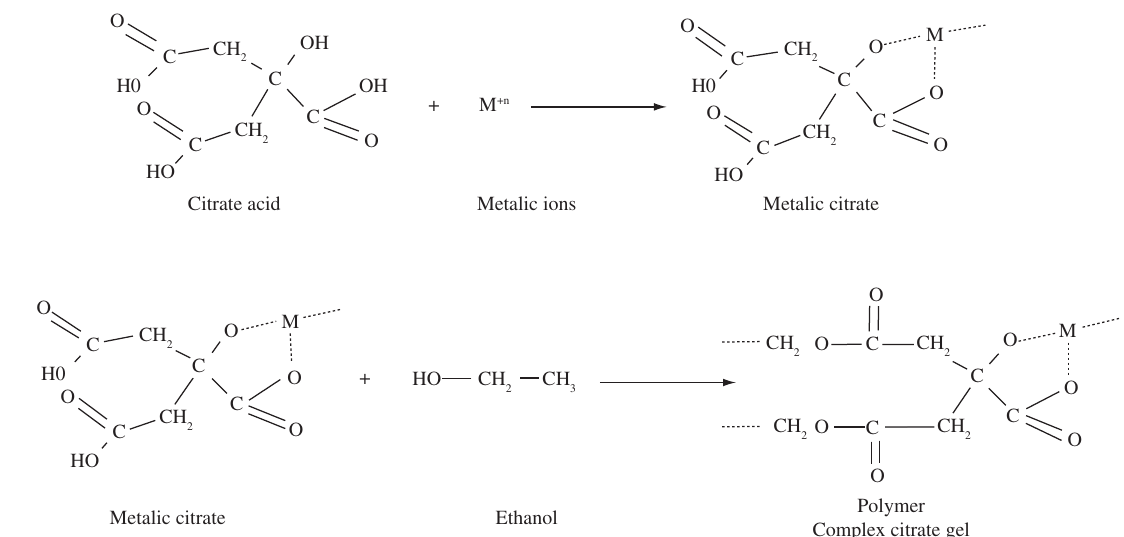
Figure 1. Reactions in citrate precursor method.